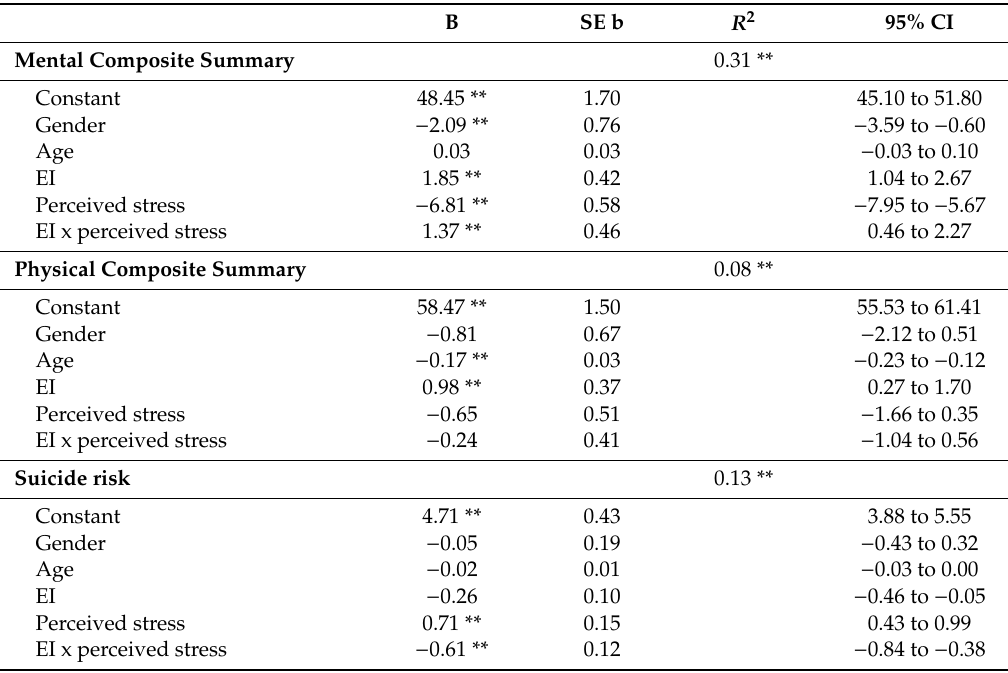
Table 3. Tested dependent variable models with mental health composite, physical health composite and suicide risk as outcomes for long-term unemployment.